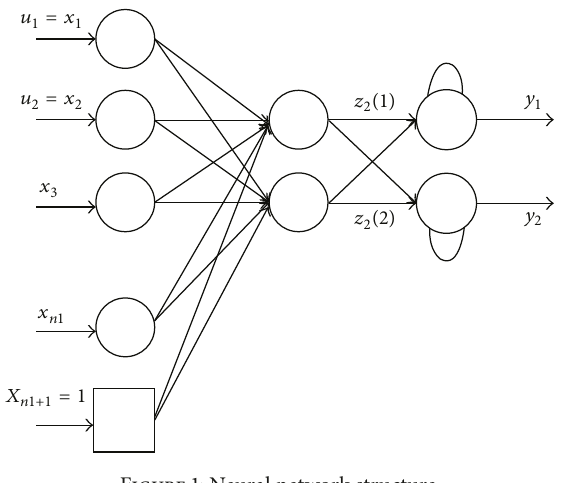
Figure 1: Neural network